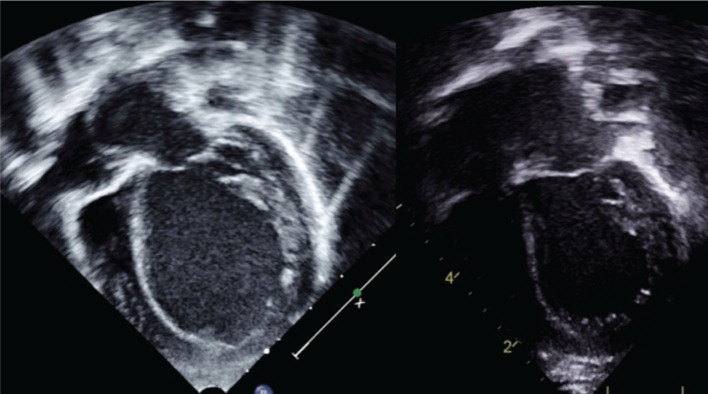
Pacemaker-induced cardiomyopathy in a four-month-old with congenital atrioventricular block before and at two weeks after a left ventricular lead was added.